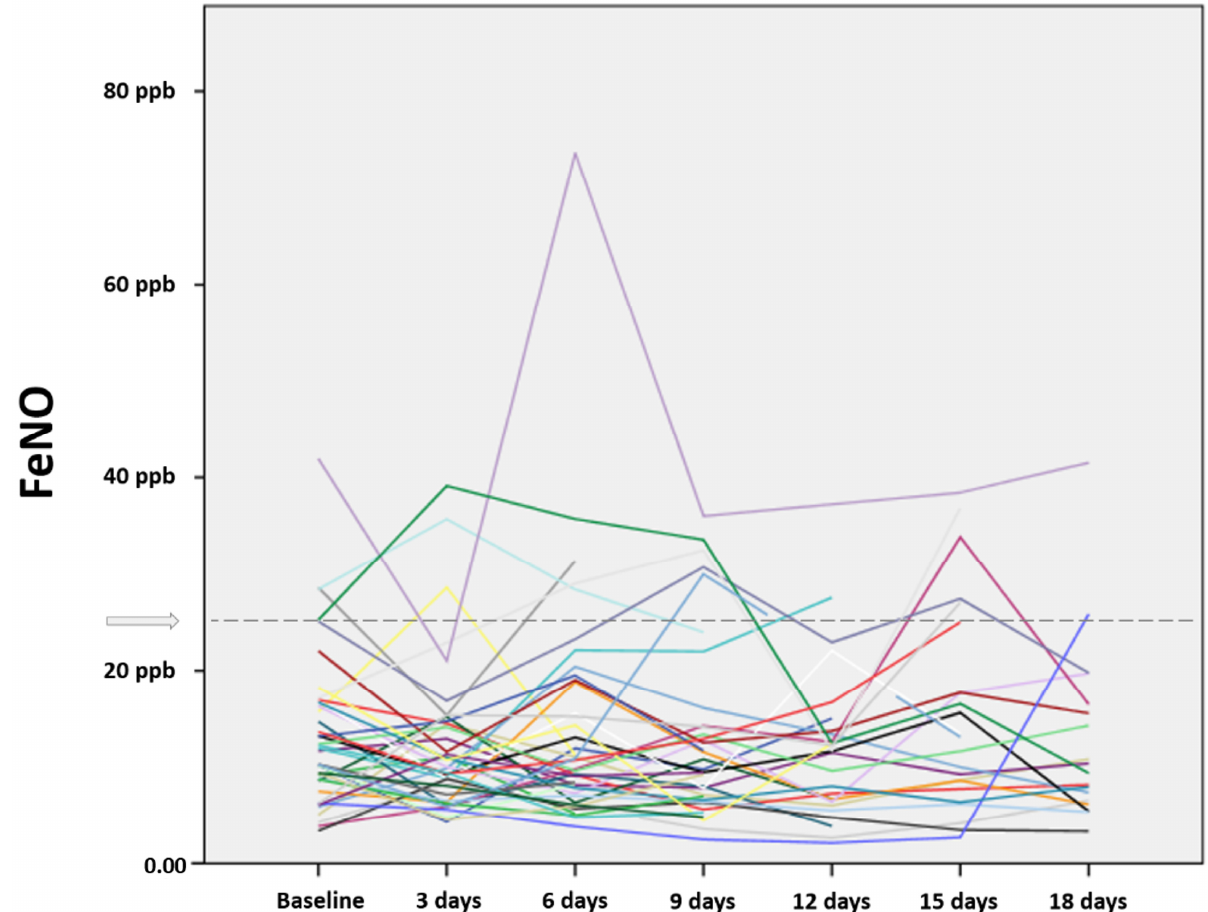
Figure 1. Individual fractional exhaled nitric oxide (FeNO) values in 41 stable chronic obstructive pulmonary disease (COPD) patients measured at different time-points spaced 3 days apart. Different colors indicate different patients. The dashed grey line indicates the 25 ppb cut-off.